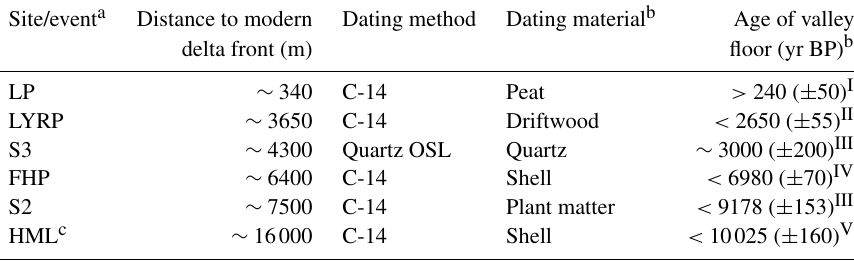
Table 1. Absolute ages from Adventdalen constraining delta propagation.